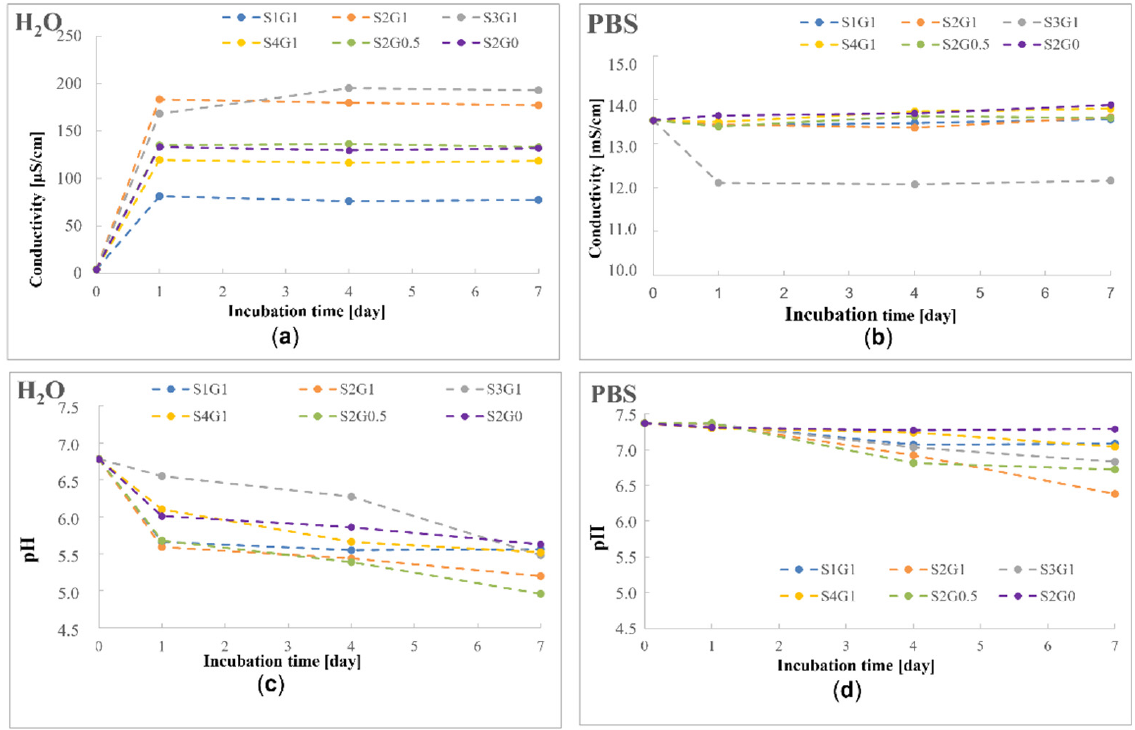
Figure 2. The changes in conductivity and pH value during the 7-day immersion at 37 °C. ( a ) Conductivity changes in distilled water; ( b ) conductivity changes in PBS; ( c ) pH changes in distilled water; ( d ) pH changes in PBS.